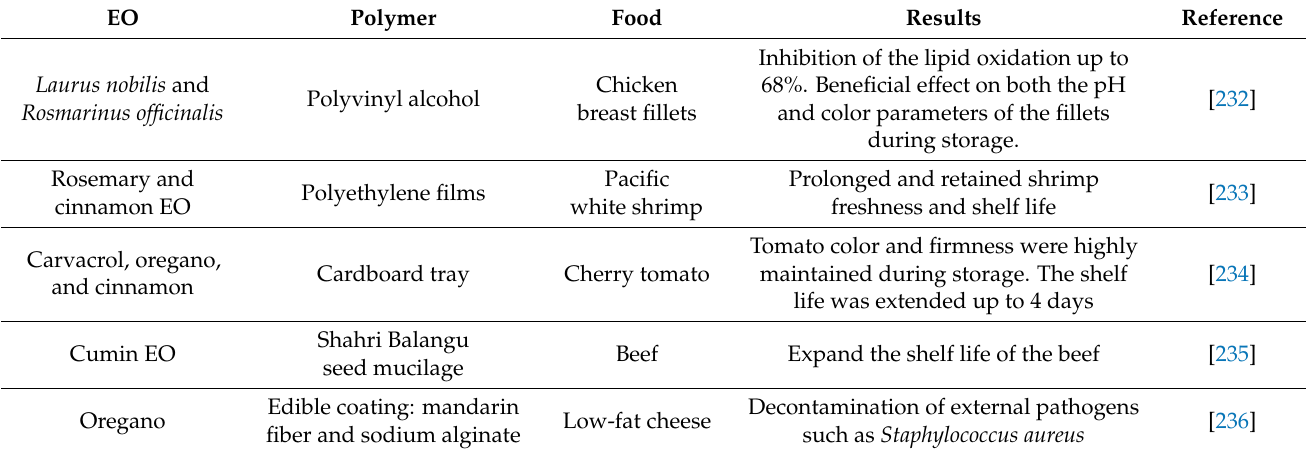
Table 4. Five selected bibliographical studies showing the beneficial use of EOs in different food packaging. EO Polymer Food Results Reference Inhibition of the lipid oxidation up to 68%. Beneficial effect on both the pH Chicken Polyvinyl alcohol and color parameters of the fillets breast fillets during storage. Pacific Prolonged and retained shrimp white shrimp freshness and shelf life Tomato color and firmness were highly Cherry tomato maintained during storage. The